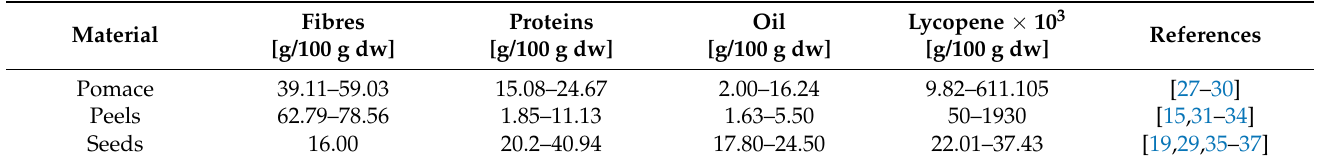
Table 1. Main compounds in tomato pomace, peels, and